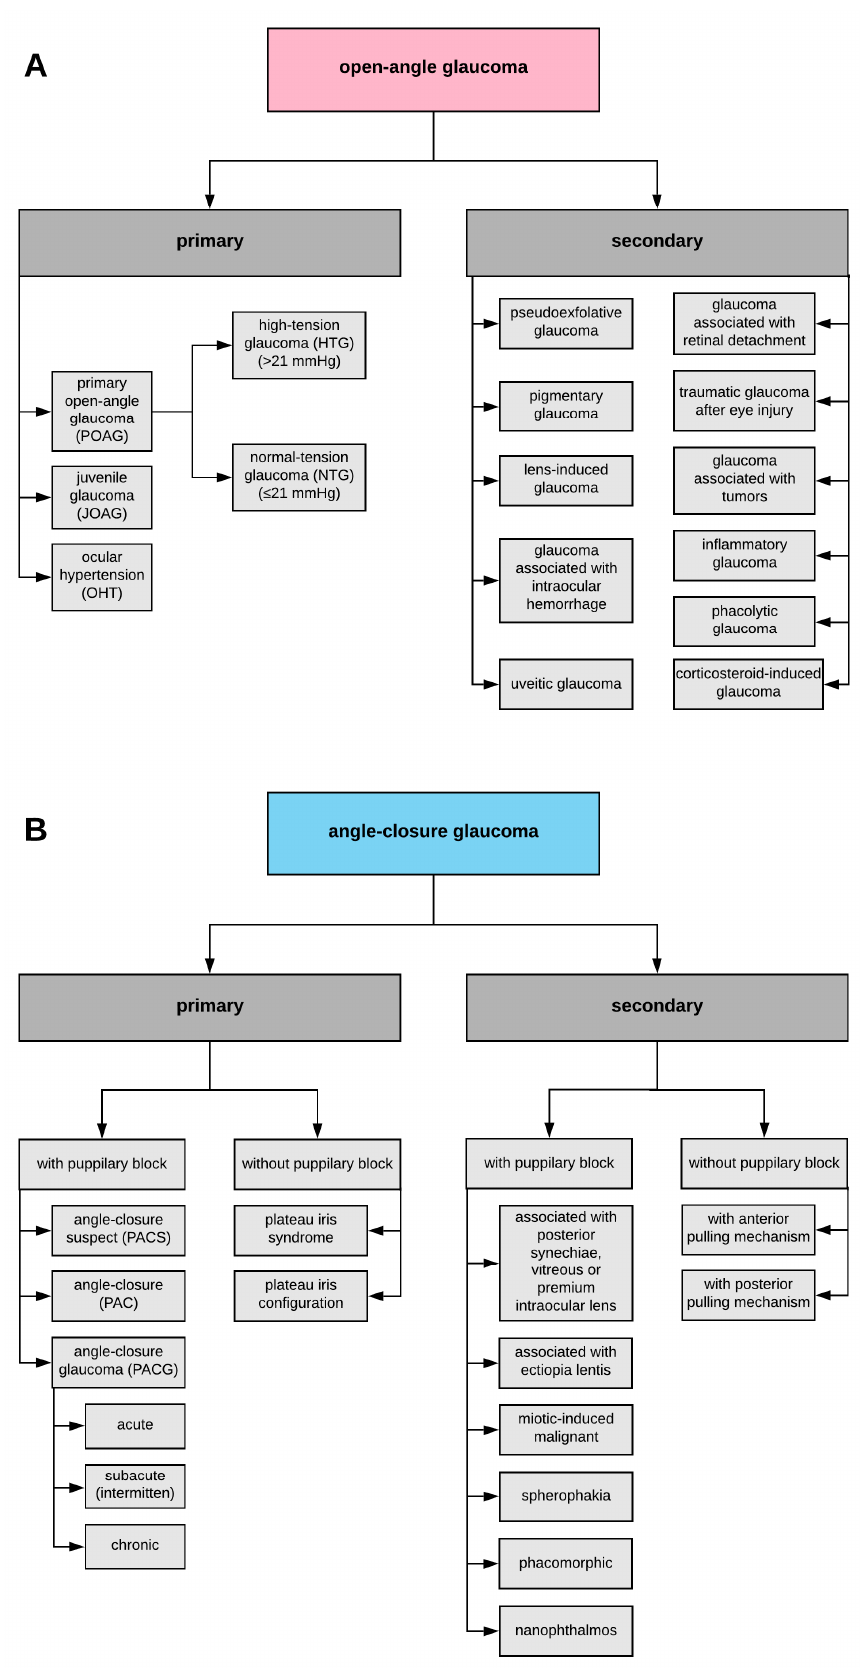
Figure 1. Clinical classification of open-angle glaucoma (OAG) ( A ) and angle-closure glaucoma (ACG) ( B ).